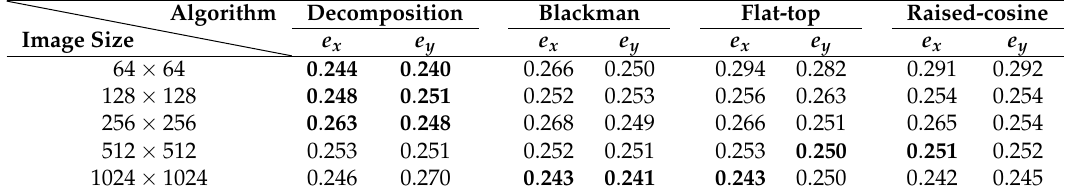
Table 3. The comparison of displacement accuracy for different methods of eliminating the effect of image border in the case of images with different sizes. e x and e y denote the mean absolute error in the x - and y -directions,